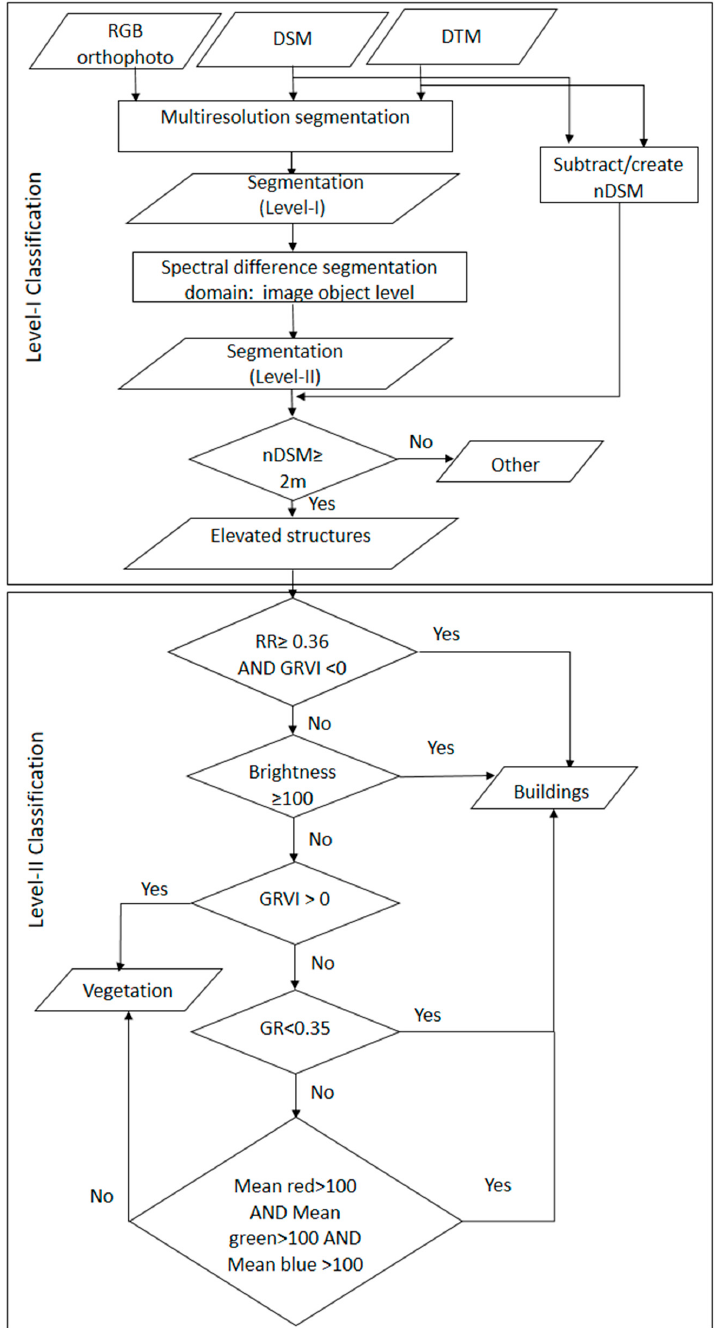
Figure 3. Created image hierarchies: Segmentation Level-I and Level-II and the implemented methodology to achieve Level-I and Level-II classification.